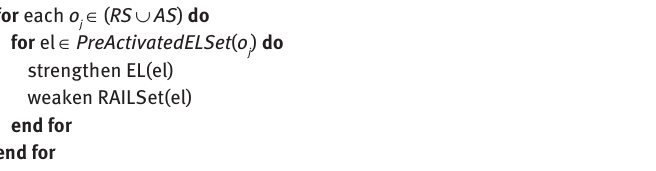
Algorithm 5: Neural Network Adjusting for Case 4